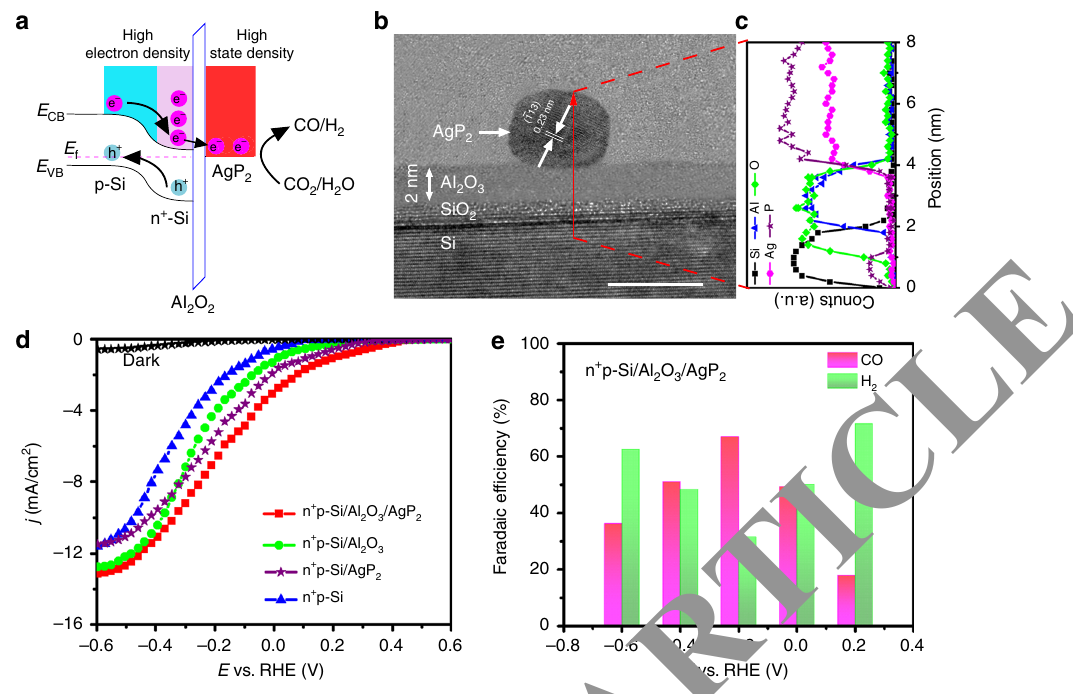
Fig. 4 Photoelectrochemical device and performance. a Schematic energy level alignment. b Cross-sectional HRTEM image of n + p-Si/Al 2 O 3 /AgP 2 hybrid photocathode and c corresponding line scan elemental EDS spectra. Scale bar 5 nm. d j – E curves of as-prepared n + p-Si, n + p-Si/AgP 2 , n + p-Si/Al 2 O 3 , and n + p-Si/Al 2 O 3 /AgP 2 photocathodes under simulated solar illumination (AM-1.5G, 100 mW cm − 2 ) in CO 2 -saturated 0.5 M KHCO 3 solution. e Faradaic ef fi ciency of CO and H 2 at different potentials for n + p-Si/Al 2 O 3 /AgP 2